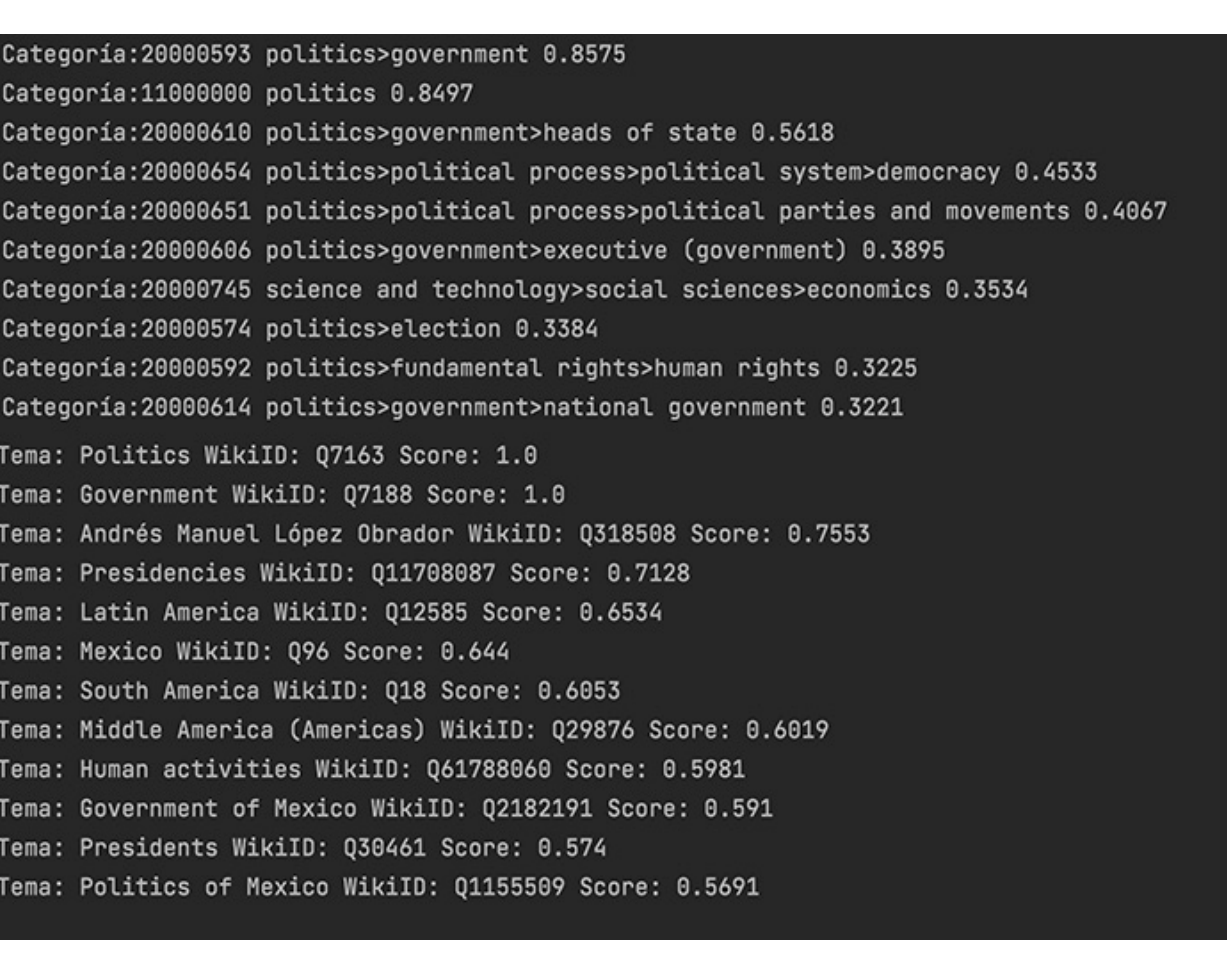
Figure 5. Classification and categorization results (partially in Spanish; ‘Categoría' stands for ‘Cat- egory’ and ‘Tema’ stands for ‘Topic').